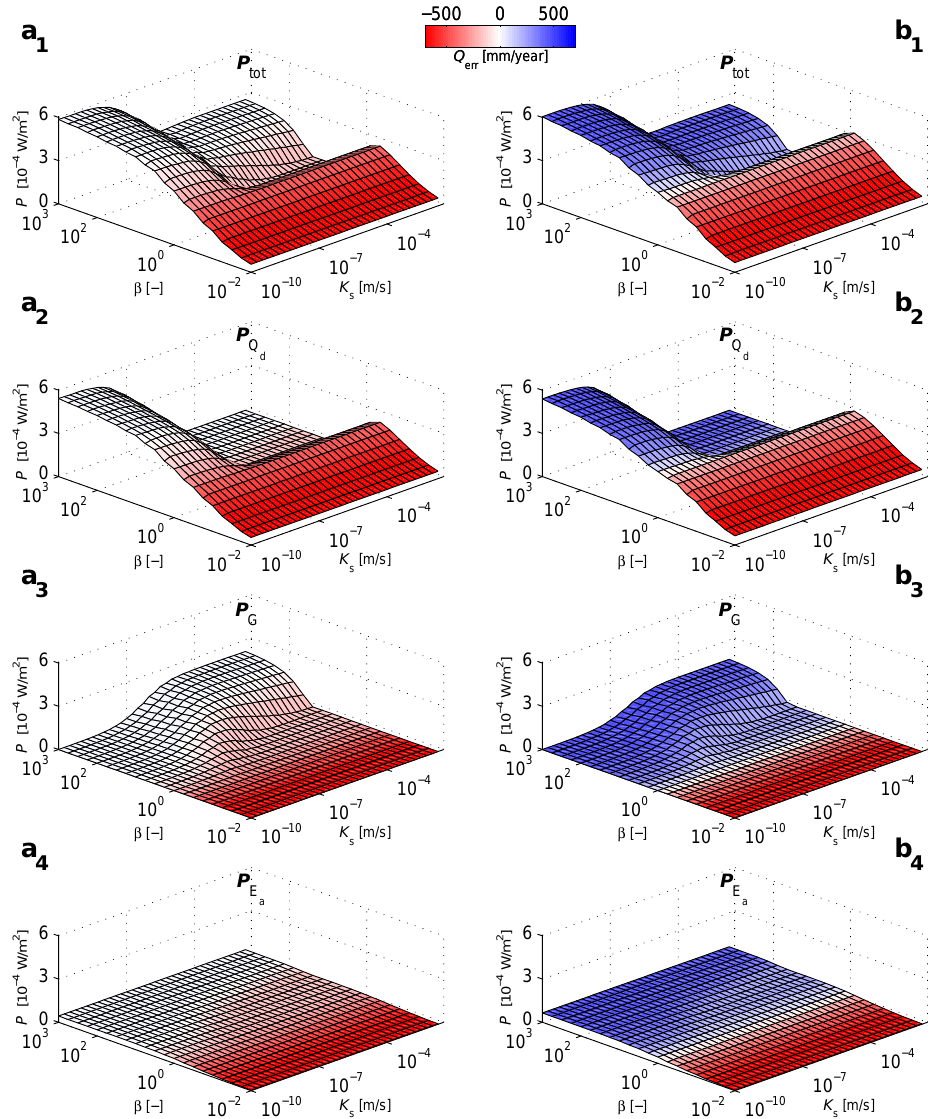
Fig. 6. Sensitivity of β and K s to power of the different fluxes leaving the unsaturated zone of the HJ Andrews watershed 2. Sensitivities for two different sets of the parameters F C , S max and albedo are shown (panels a, b; see Table 1 for the used parameters). The colour coding shows the average error in the yearly water balance ( Q err